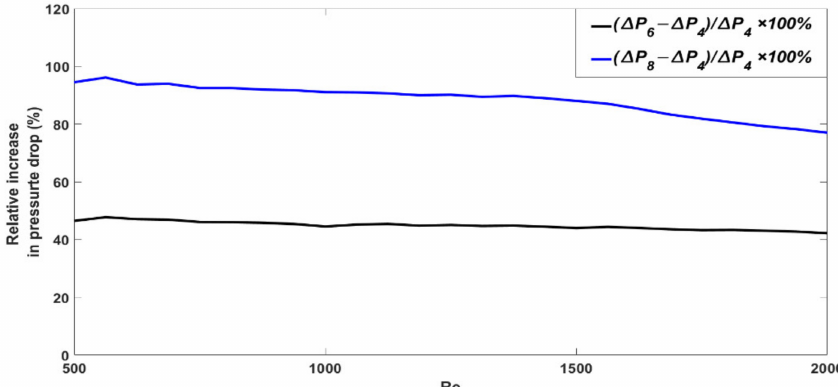
Figure 10. Relative increase in heat transfer coefficient for channel turns numbers of 6 and 8 with respect to